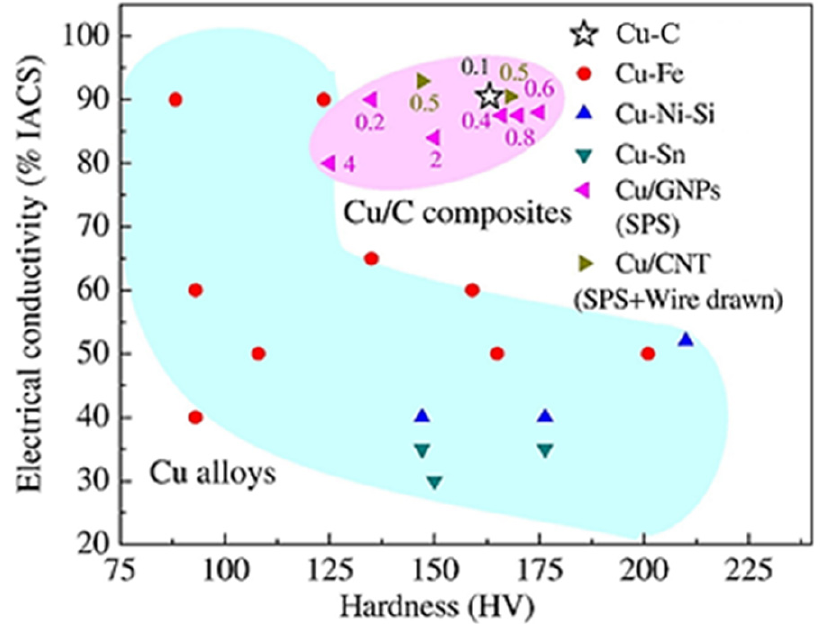
Figure 11. Electrical conductivity vs. hardness plot for dissimilar Cu-based roll bonded joints. Reproduced with permission from Ref. [79].